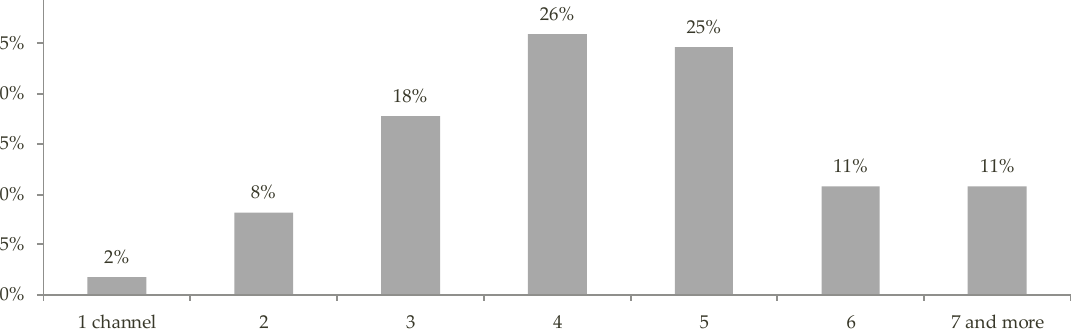
Figure 11. Multichannel activities of German wineries (average distribution channels, survey results).